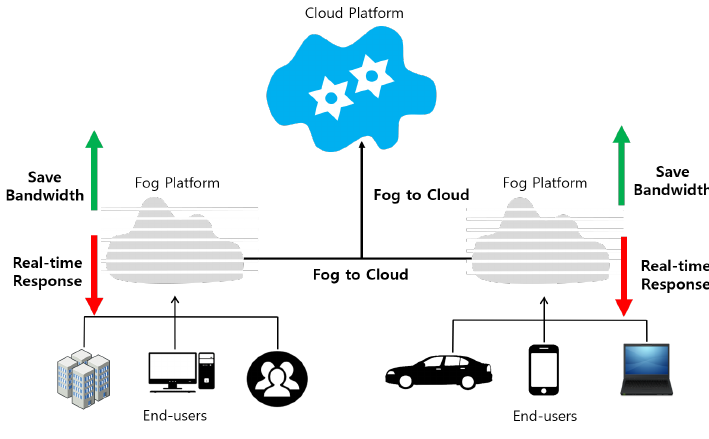
Figure 6. Overview of fog